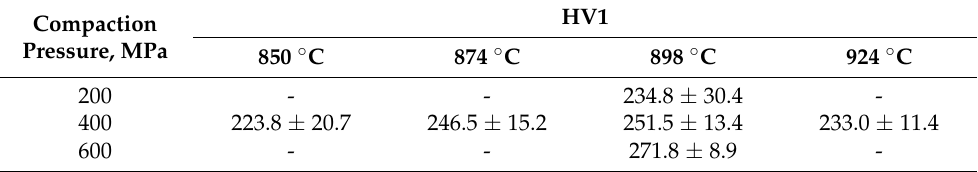
Table 6. Effect of compaction pressure and sintering temperature on as-sintered hardness.